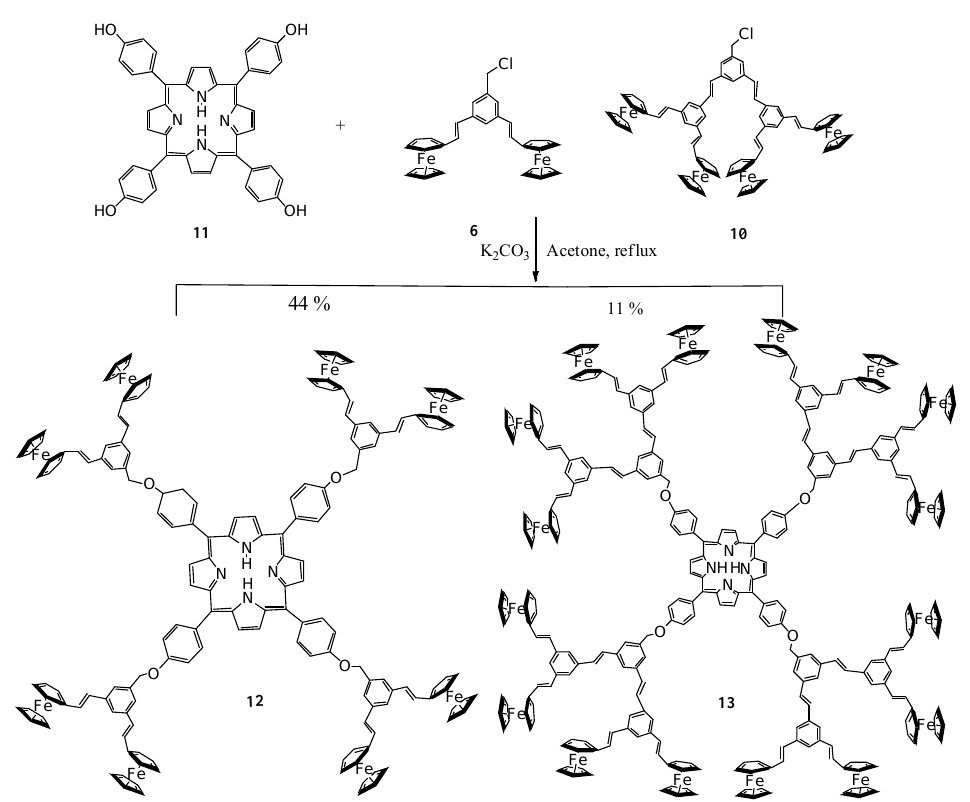
Scheme 2. Synthesis of the dendrimers containing a porphyrin core and ferrocene units in the periphery.